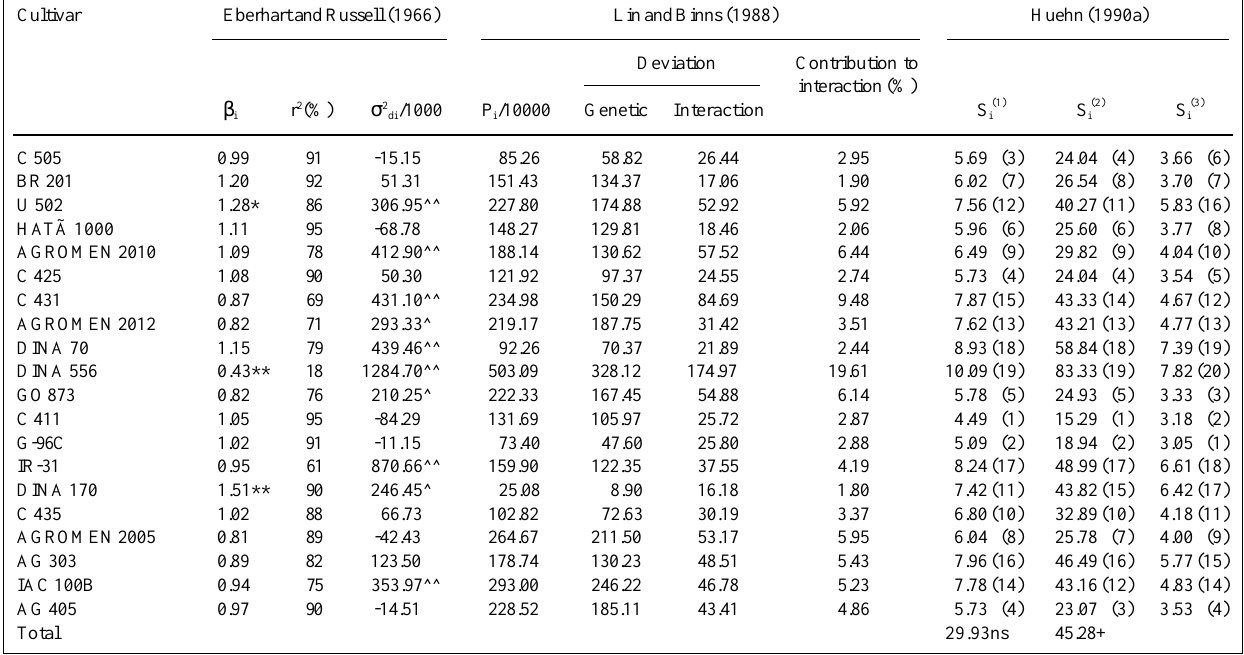
Table III - Estimates of the stability parameters proposed by Eberhart and Russell (1966), Lin and Binns (1988) and Huehn (1990a) for grain yield (kg/ha) of 20 maize hybrids evaluated in 10 environments. Cultivar Eberhart and Russell (1966)